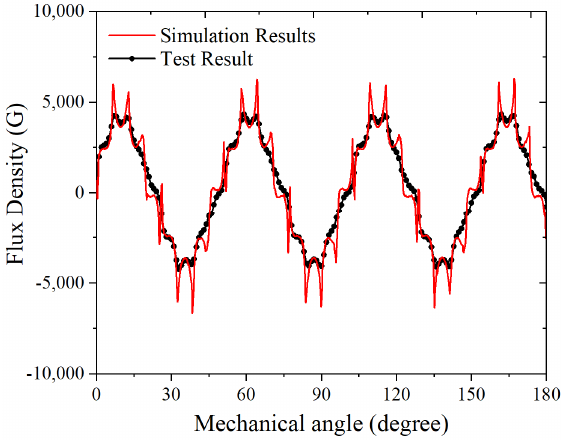
Figure 12. Comparison of flux density on PM.